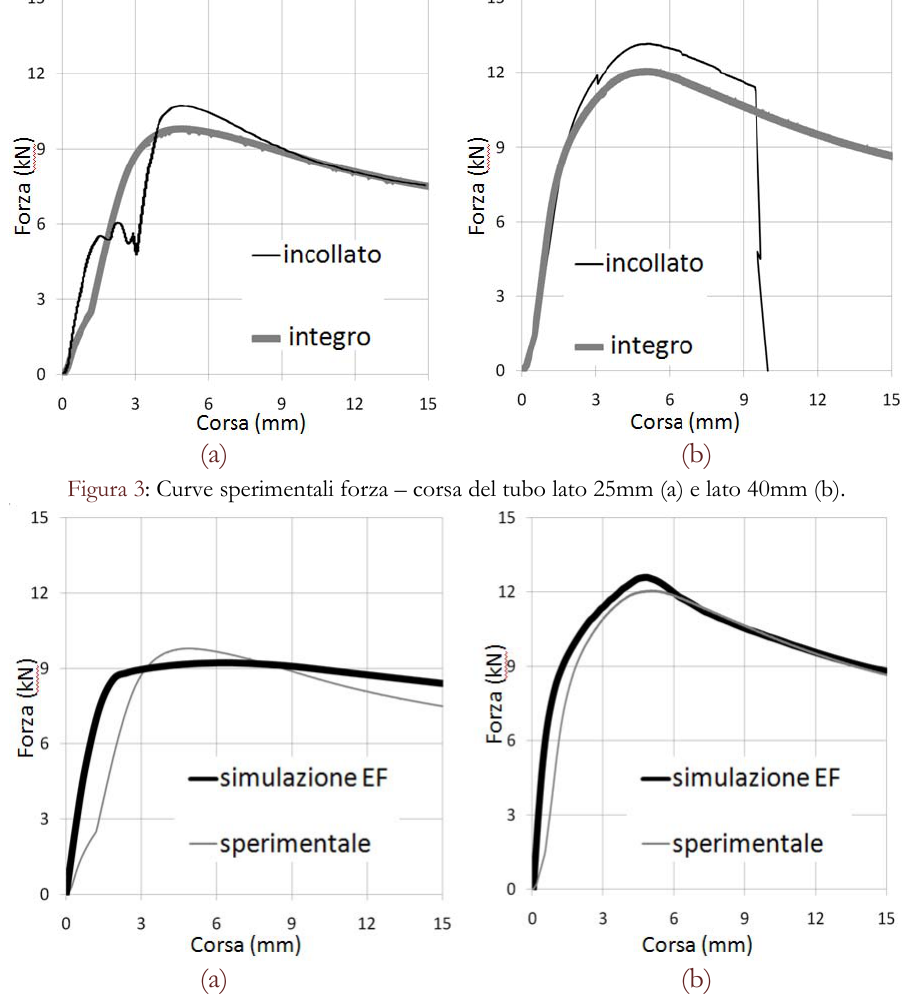
Figura 4: Confronto numerico-sperimentale tubo integro lato 25mm (a) e lato 40mm (b).